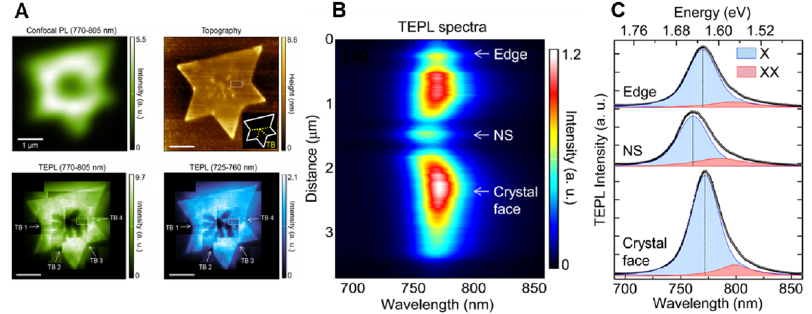
Figure 12: (A) PL images of a WSe 2 monolayer measured with confocal microscopy (top) andTEPLmicroscopy(bottom,theintegrated intensity of 770 – 805 nm and 725 – 760 nm) with the corresponding AFM topography. (B) TEPL spectra along the center axis of a WSe 2 monolayer. (C) TEPL spectra with peak energies of 1.610 eV at the edge, 1.630 eV at the nuclear site (NS), and 1.606 eV at the crystal face. Exciton (blue) and biexciton (red)peaksare fi